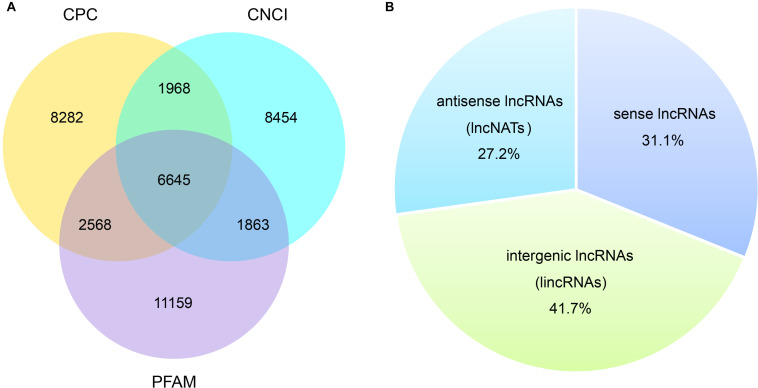
Prediction of novel lncRNA of V. destructor. (A) Venn analysis of the putative novel lncRNAs by using CPC, CNCI, and PFAM. (B) The source and distribution percentage of the novel lncRNAs based on the intersection of Venn diagram.